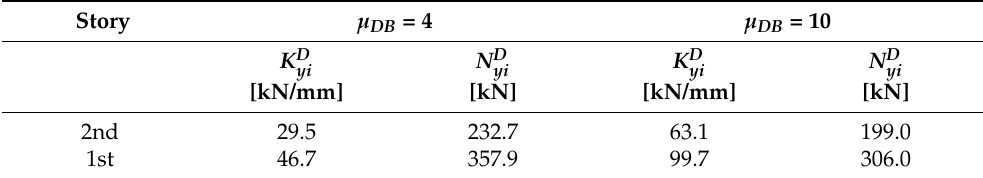
and yield force N D of the dampers at each story in yi yi